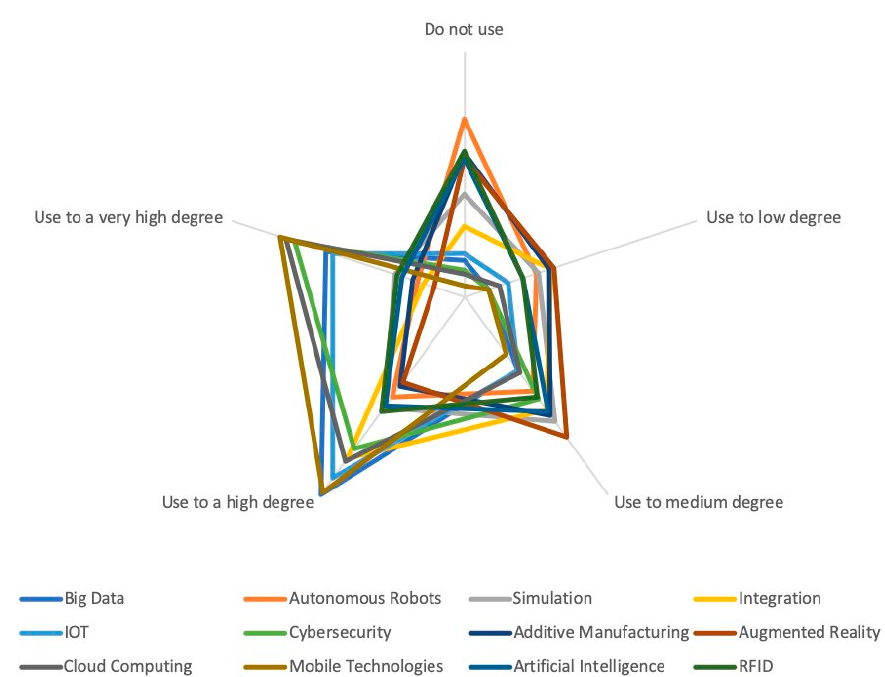
Figure 6. Industry 4.0 technologies (radar chart in terms of scales).